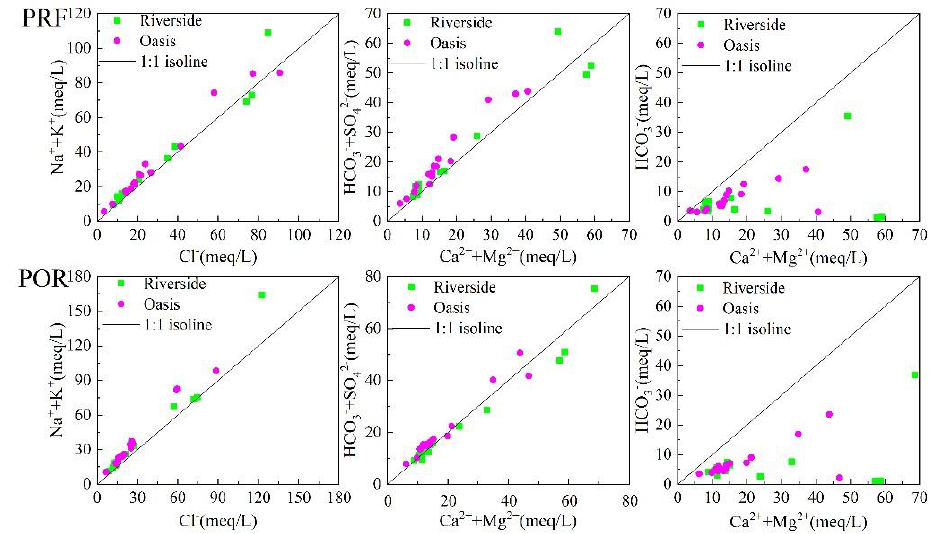
Figure 7. Ratio of major ions in